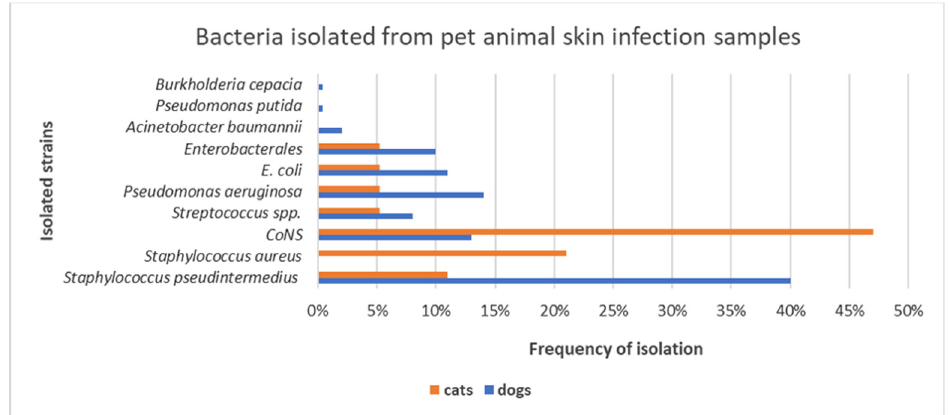
Figure 5. Frequency of isolation of bacterial species from skin infection samples in dogs and cats in the years 2016–2019.